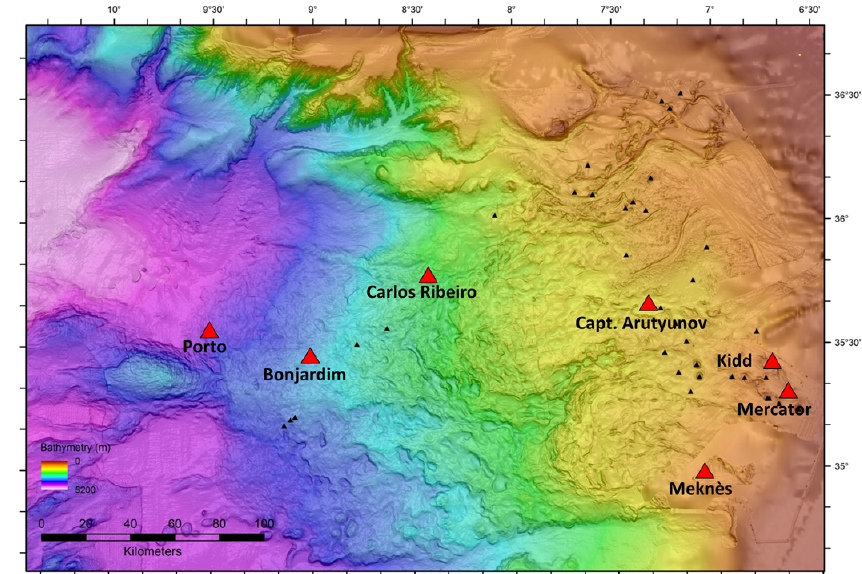
Fig. 1. Map of the study area in the Gulf of Cadiz. Large red triangles: location of the seven studied mud volcanoes; small black triangles: other mud volcanoes in the area; the two reference stations (not shown) are located in the vicinity of Mercator and Kidd mud volcanoes. Bathymetry from Zitellini et al.